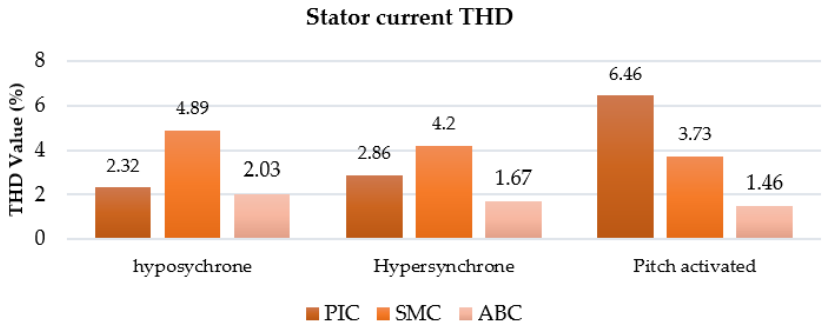
Figure 16. Bar graph showing stator current THD under: PIC, SMC, and ABC in hyposynchronous, hypersynchronous, and pitch activation modes of operation.